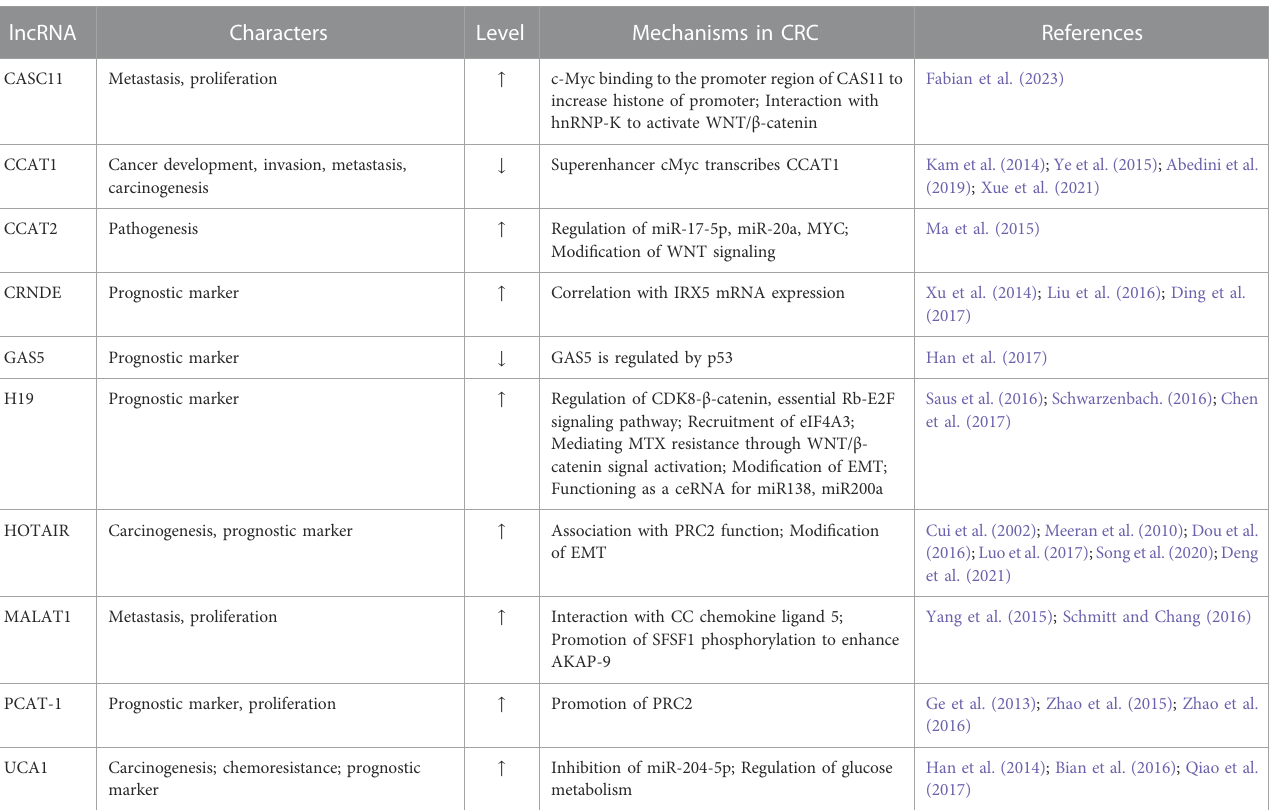
TABLE 1 lncRNAs associated with colorectal